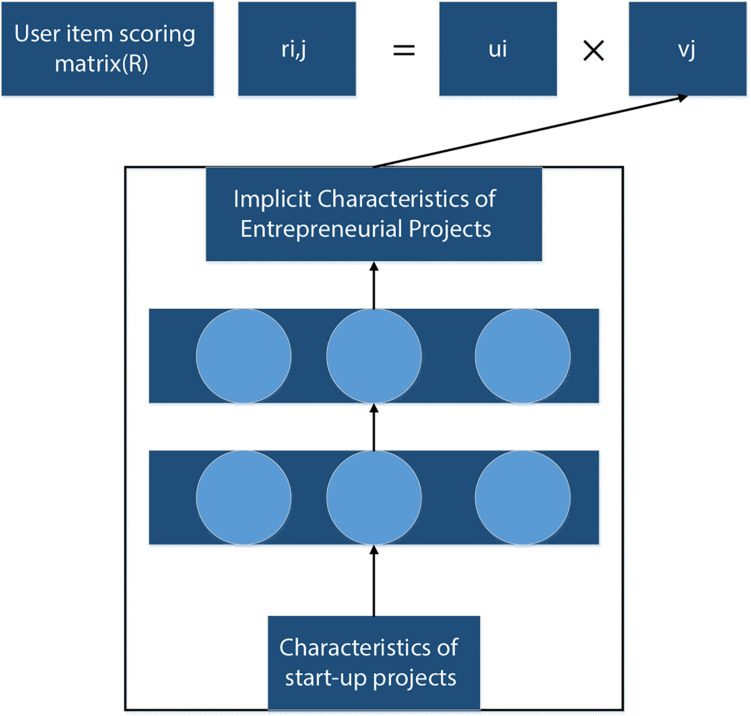
Schematic diagram of recommendation algorithm structure of entrepreneurial project based on optimized deep neural network.